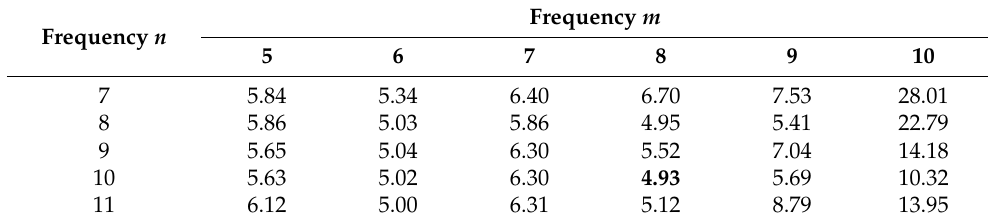
Figure 6. MAE reciprocal corresponding to different frequencies. Table 2. MAE corresponding to different frequencies (cm).